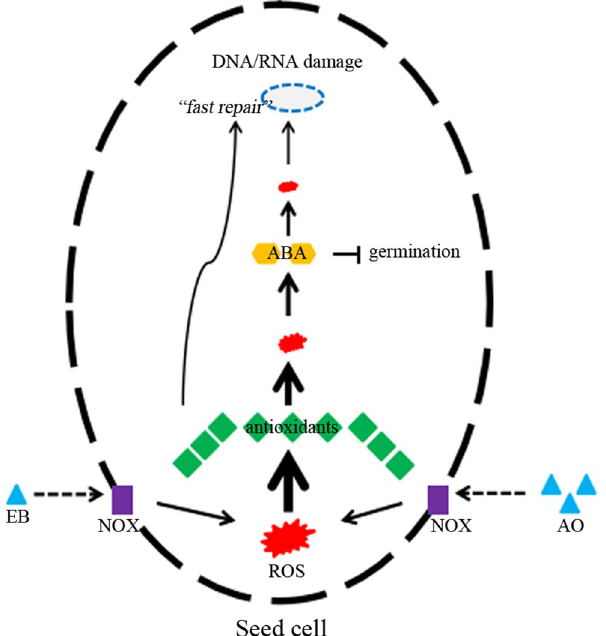
Figure 8. Model of the germination responses of different coloured maize seeds. The hypothetical model, based on ROS scavenging capacity, illustrates the germination responses of different coloured maize seeds following exposure to mutagens. NOX, NADPH oxidase; AO, acridine orange; EB, ethidium bromide; ABA, abscisic acid; ROS, reactive oxygen